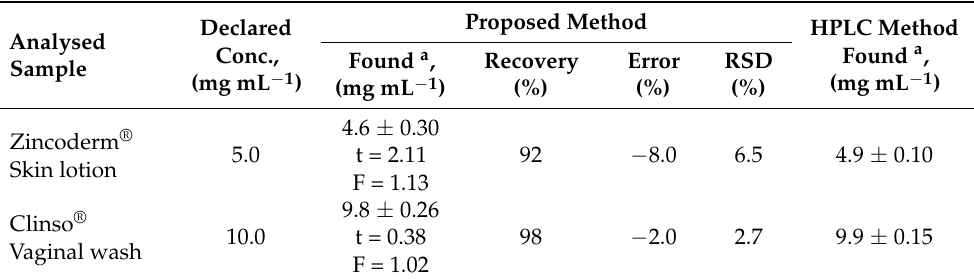
Table 7. Analysis of CTAB in personal care products using the developed Cu-PCV flow injection